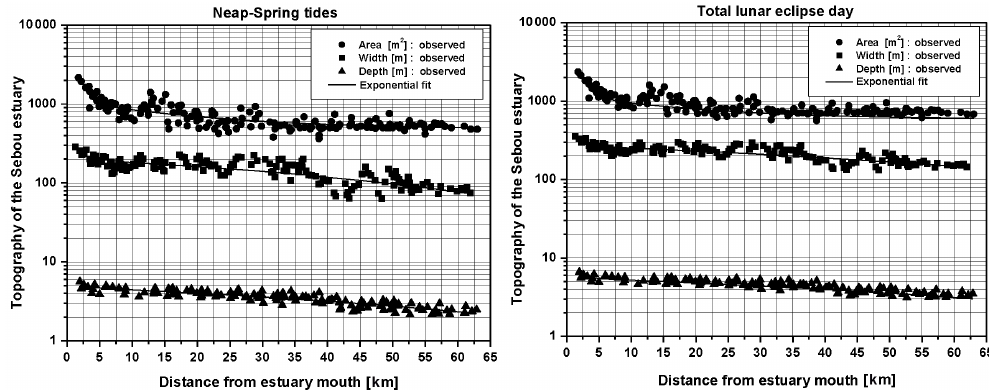
Figure 5. Geometry of the Sebou estuary, showing the cross-sectional area A (m 2 ), the width B (m) and the estuary depth h (m) during neap–spring and total lunar eclipse tides.